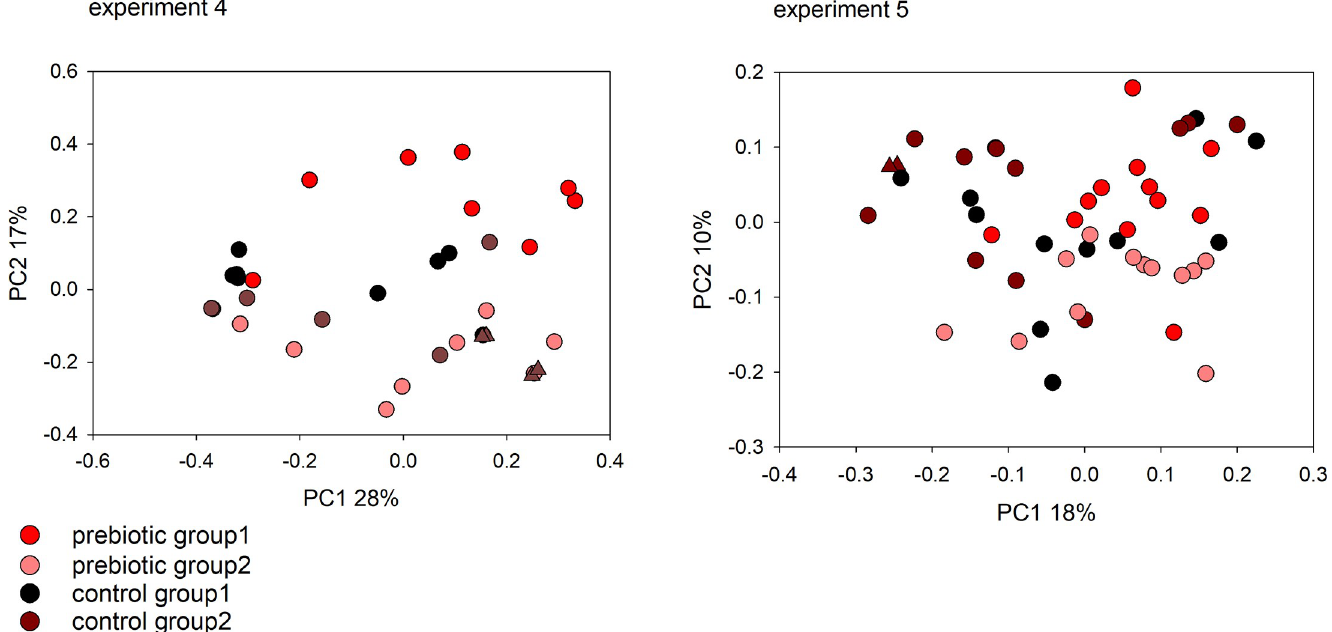
Fig 4. Impact of diet on the fecal microbiome of C . parvum (experiment 4) and C . tyzzeri (experiment 5) infected mice. Principal Coordinate Analysis was used to display weighted UniFrac distances between pairs of fecal microbiome samples. Experiment 4 analysis includes data from 50 fecal samples. For experiment 5, 49 samples were analyzed from individual mice. Each data point represents one sample, color-coded according to treatment and group as shown in Fig 2. Matching triangle symbols indicate replicate analyses of the same fecal samples.